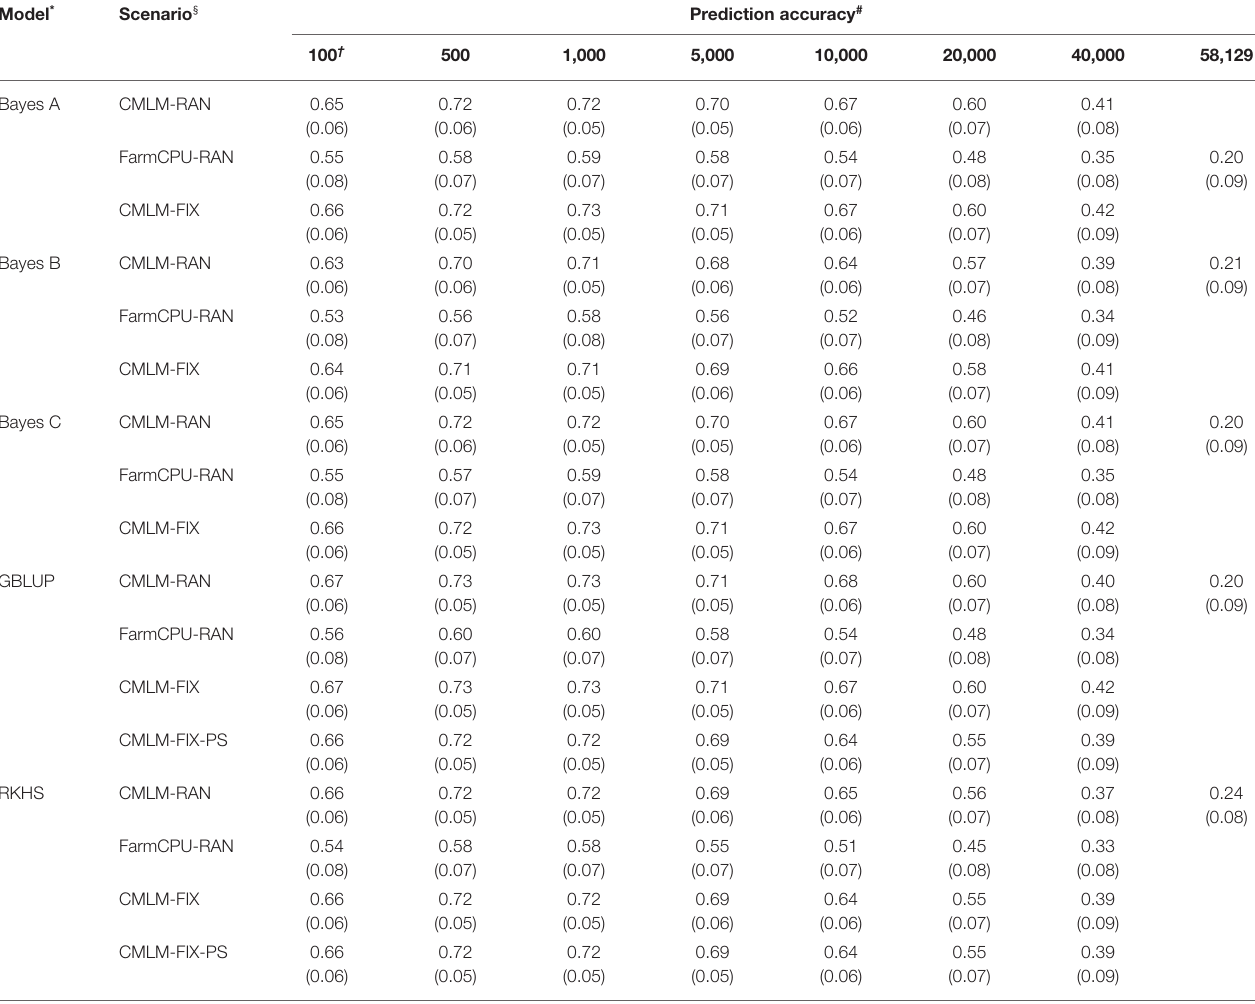
TABLE 4 | Prediction accuracy of random model, fixed model, and population structure model based on trait-associated markers in five prediction models for thousand kernel weight. Model